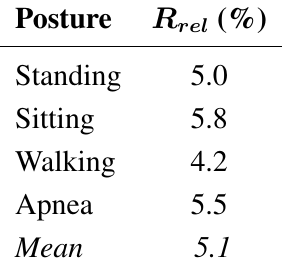
, of mean beat-to-beat lengths, BB rel